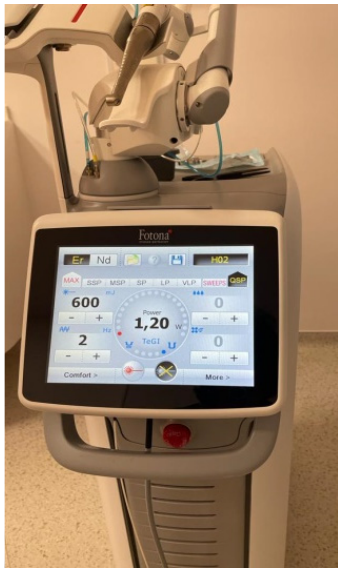
Figure 1. Er:YAG laser device (LIGHTWALKER AT S, M021-5AF/1 S, Fotona d.o.o., Ljubljana, Slovenia).